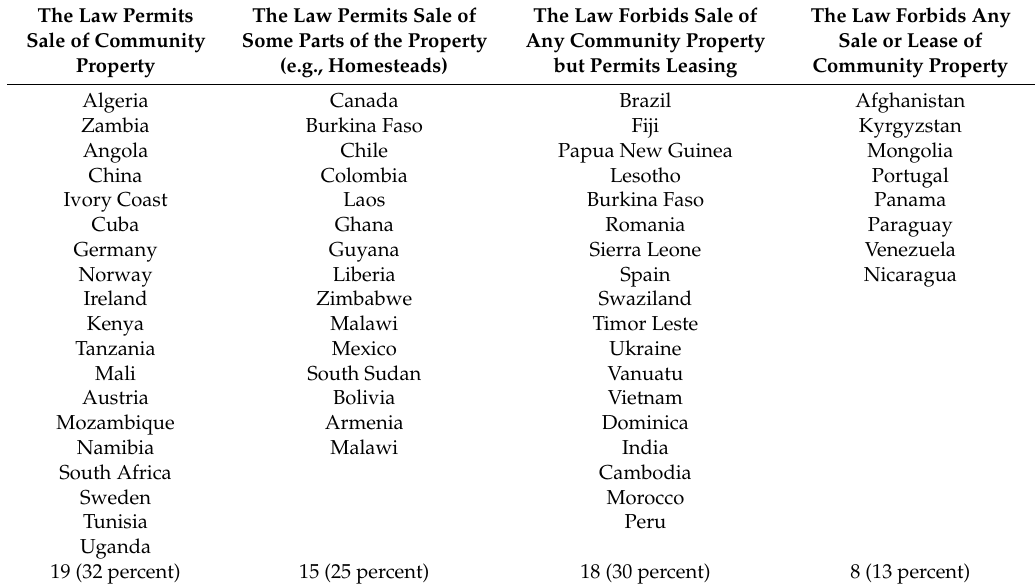
Table 8. The Legal Right of Communities to Sell their Property in a Sample of 60